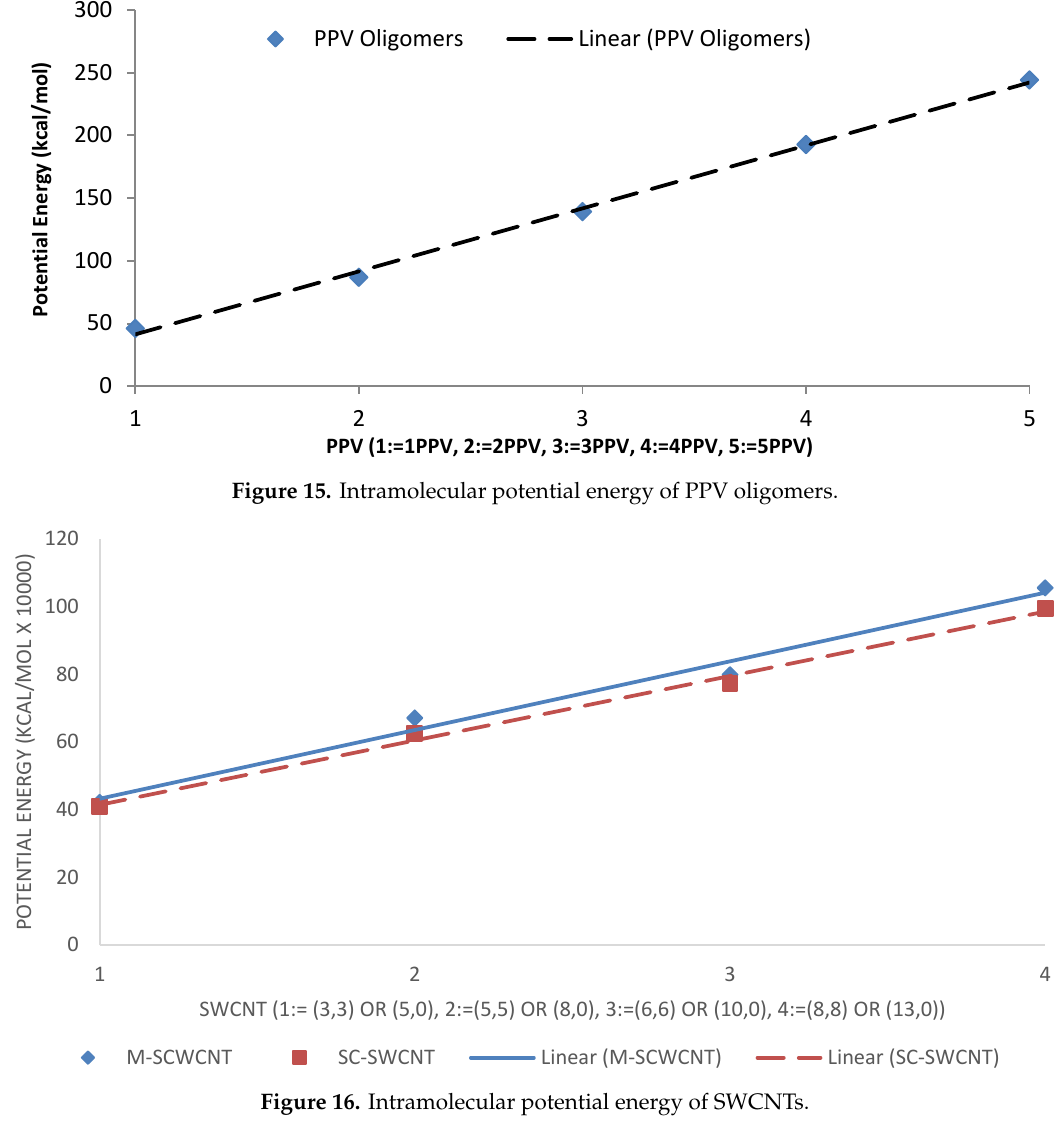
Figure 17. Initial configuration of 4PPV–7 nm × 7 nm graphene interaction.